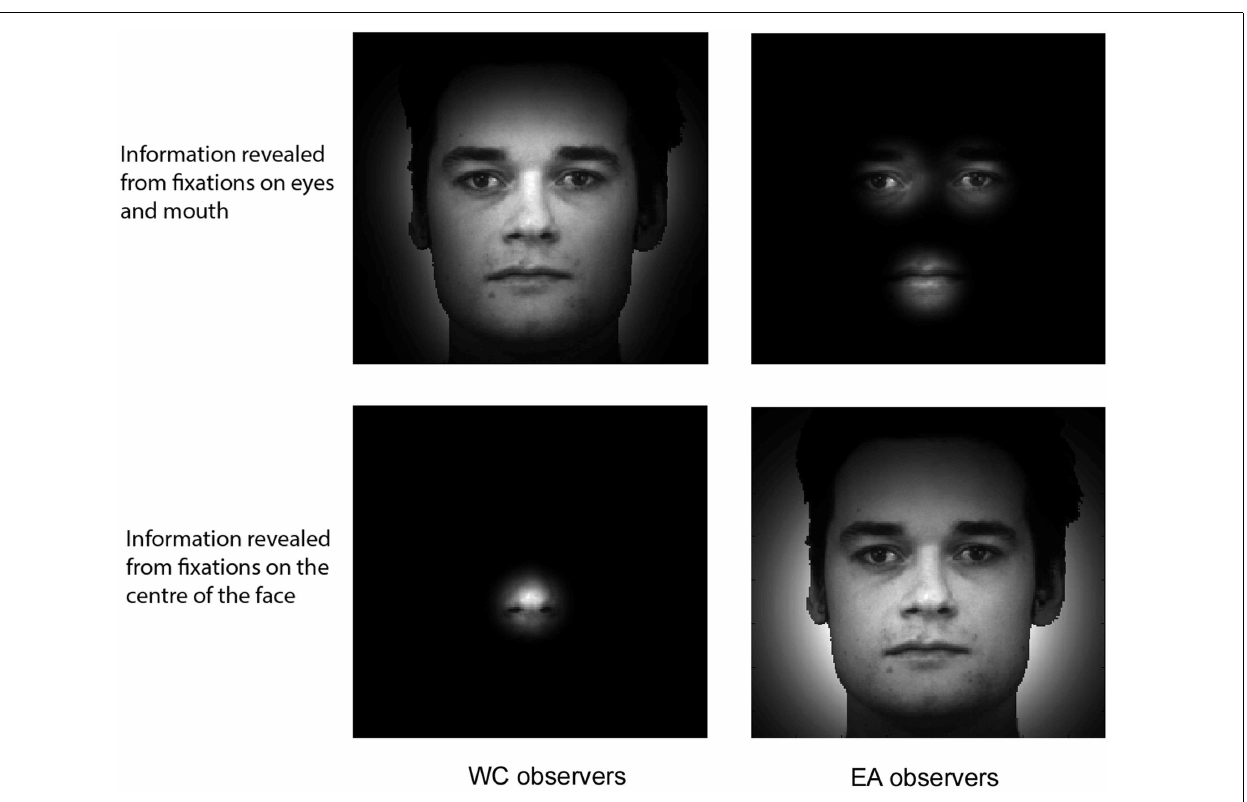
FIGURE 3 | Reconstructed available information as a function of facial fixation locations and the culture of the observer. The size of the Gaussian aperture is determined by the expansion rate of the Expanding Spotlight and the average fixation duration in the corresponding significant